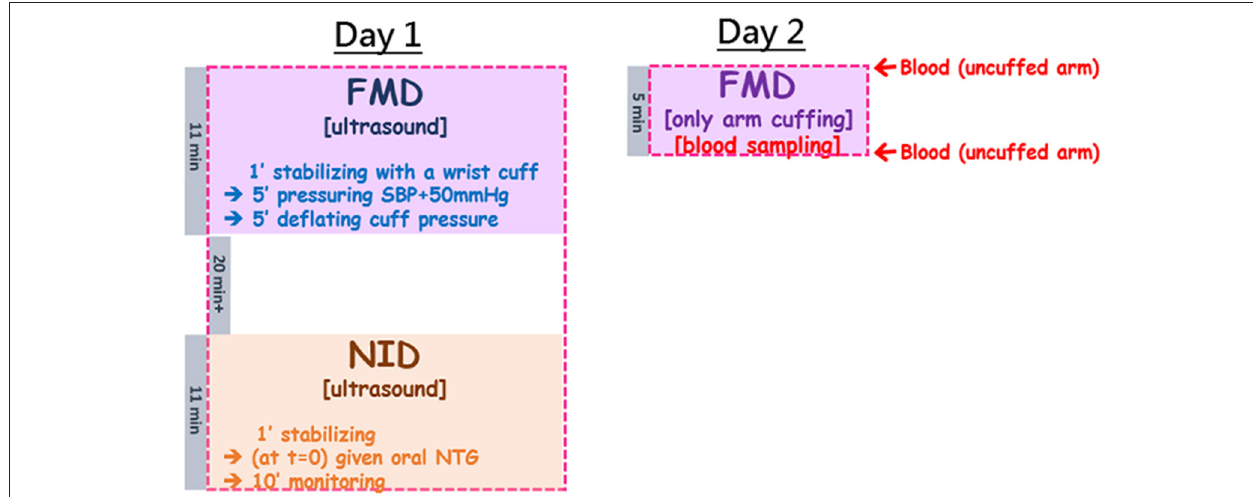
FIGURE 1 | The study flow chart combined ultrasound measurements of FMD and NID, and blood sampling before cuffing and right upon pressure deflation which allowed assessment of plasma NOx changes by arterial occlusion during FMD. The study was arranged in two separate days: Day 1 for ultrasound-based tests; Day 2 for blood sampling before and after 5-min brachial arterial constriction. In Day 1, the subject was started with the ultrasound measurement for FMD, followed by a minimal 20-min break to allow recovery of the tested brachial artery, and then the second ultrasound measurement for NID. FMD took ∼ 11min (including 1 minute of stabilization, 5min of cuff pressuring to 50 mmHg above the subject’s SBP, and another 5min of observation after wrist cuff deflation). The NID measurement also began with 1-min stabilization, followed by oral administration of NTG and then 10-min monitoring of the changes of the brachial arterial diameter. In Day 2, the setting was very similar to FMD in Day 1 (5min of pressuring to 50 mmHg above the subject’s SBP), but ultrasound was replaced by blood sampling before and after